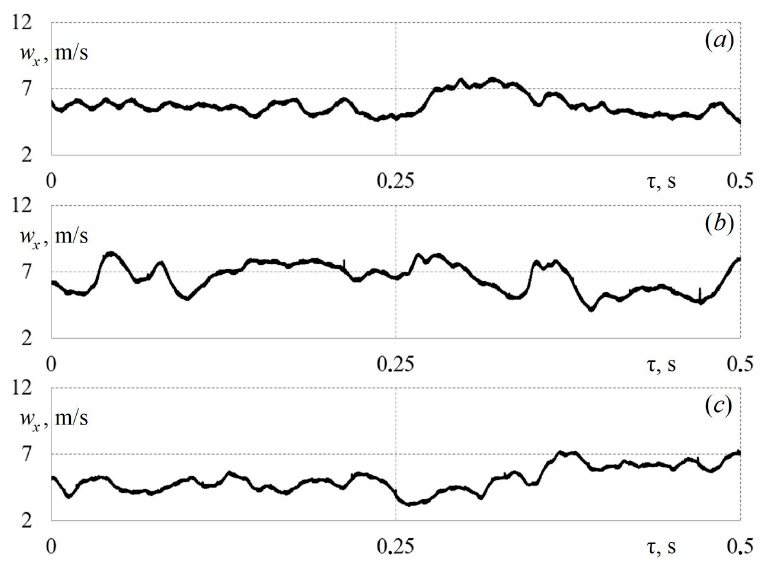
Figure 4. Dependences of local values of air flow velocity w x on time τ in the third control section ( H 3 = 500 mm) for a sensor in the centre of the set-up ( l 5 = 50 mm) for various supply tube configu- rations: ( a )—round tube (average parameters in the section: w 3 = 4.81 m/s, TI = 0.124); ( b )—square tube ( w 3 = 4.85 m/s, TI = 0.313); ( c )—triangular tube ( w 3 = 4.79 m/s, TI = 0.199).